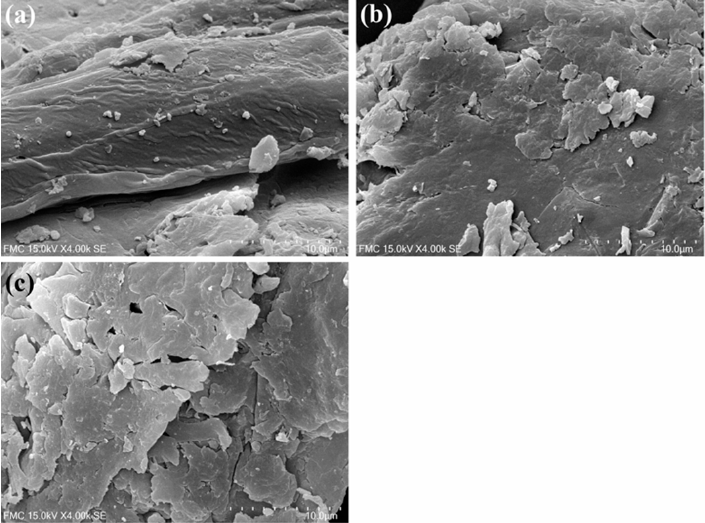
Figure 2. SEM micrographs of SCB samples at 4000 × magnification: ( a ) before treatment; after MWI treatment with NaOH 3% at 140 °C for 60 min in the ( b ) water-based medium and in the ( c ) sulfolane-based medium.